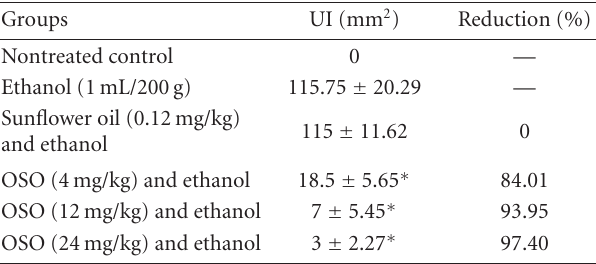
Table 1: Gastric ulcer index (UI, mm 2 ) in rats treated with abso- lute ethanol using di ff erent doses of OSO and the percentage of re- duction of the lesions. UI was measured by stereoscopy (Carl Zeiss, Berlin, Germany) and the sum of the products was expressed in terms of the ulcer index (UI, Square millimeters) and % of reduc- tion. The results are the means ± s.e.m. of five stomachs samples.